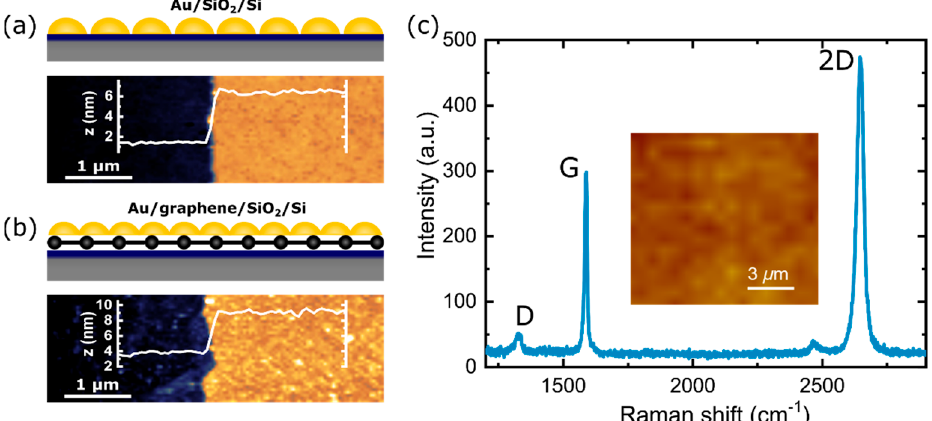
Figure 1. Schematic (top) and atomic force microscopy (AFM) (bottom) images and their cross-section of the edge of the gold film with a thickness of 4 nm deposited on ( a ) SiO 2 / Si and ( b ) graphene / SiO 2 / Si substrates. ( c ) Raman spectra of monolayer CVD graphene. The insert in ( c ) is a Raman map of graphene before the deposition of the gold film.